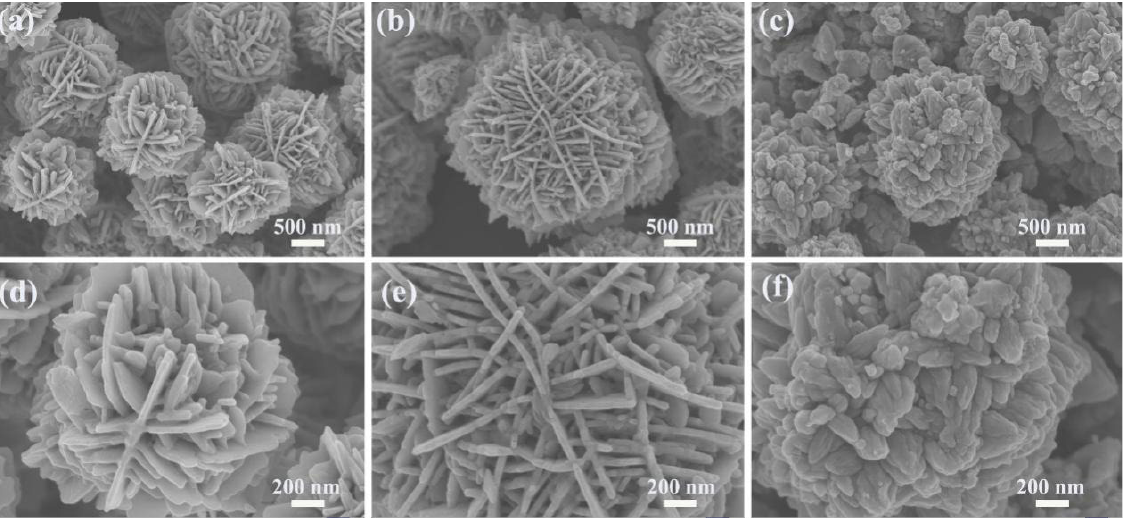
Figure 3. SEM images of ZnO nanosheet flowers assisted by different concentrations of malic acid: ( a , d ) 11 mmol; ( b , e ) 15 mmol; ( c , f ) 18 mmol.